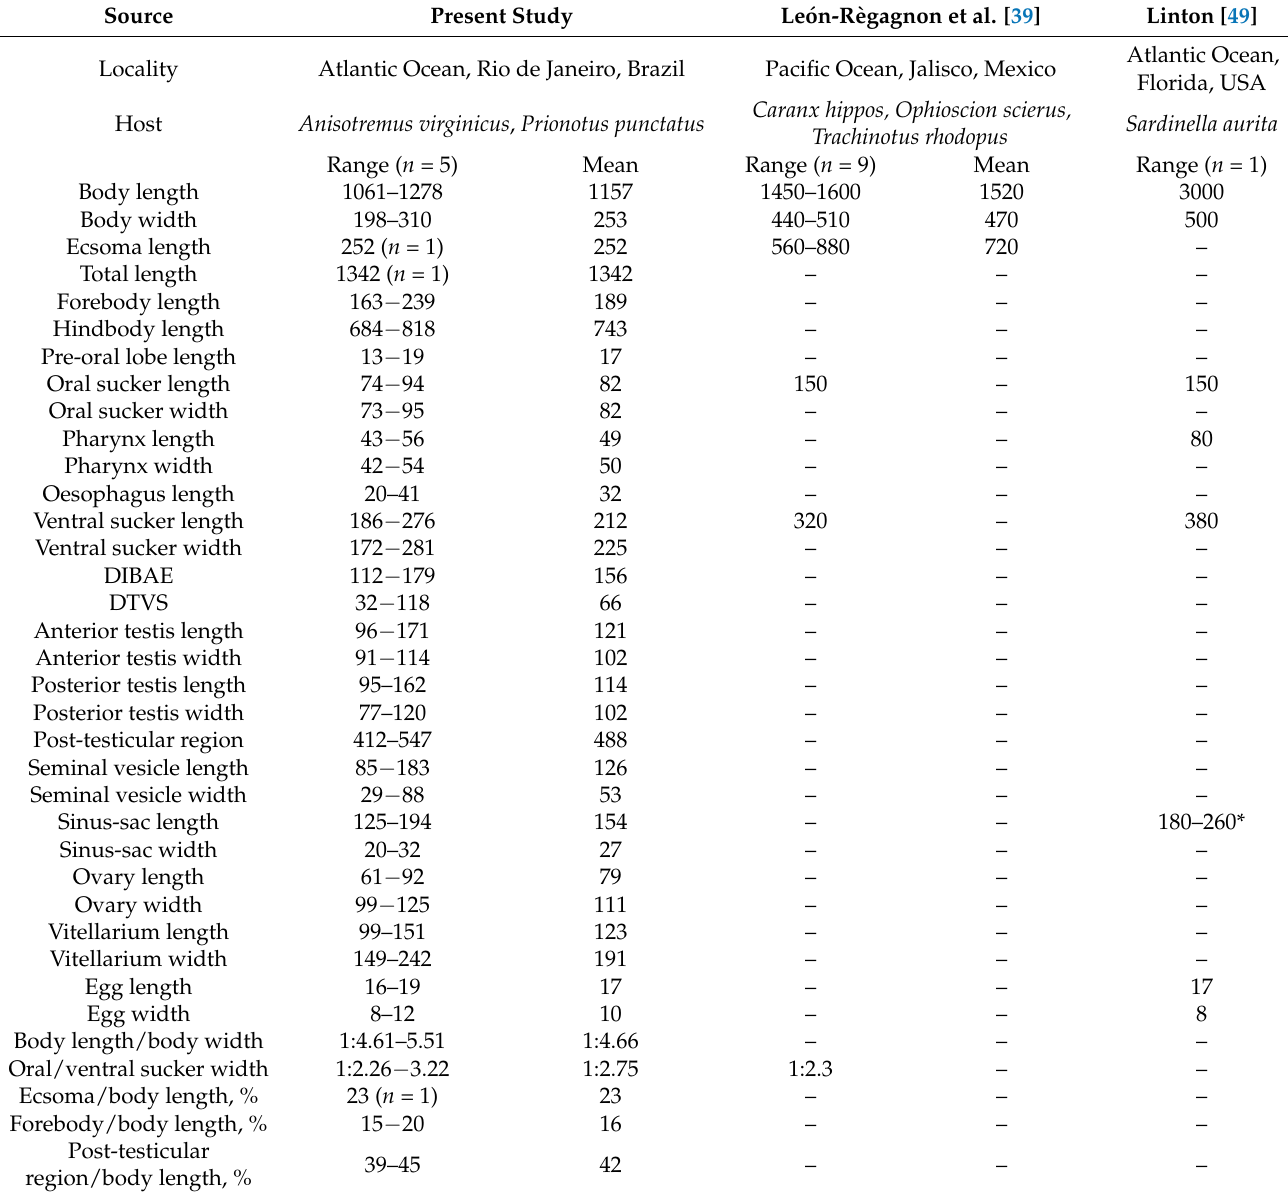
Table 2. Comparative metrical data of Ectenurus virgula Linton,